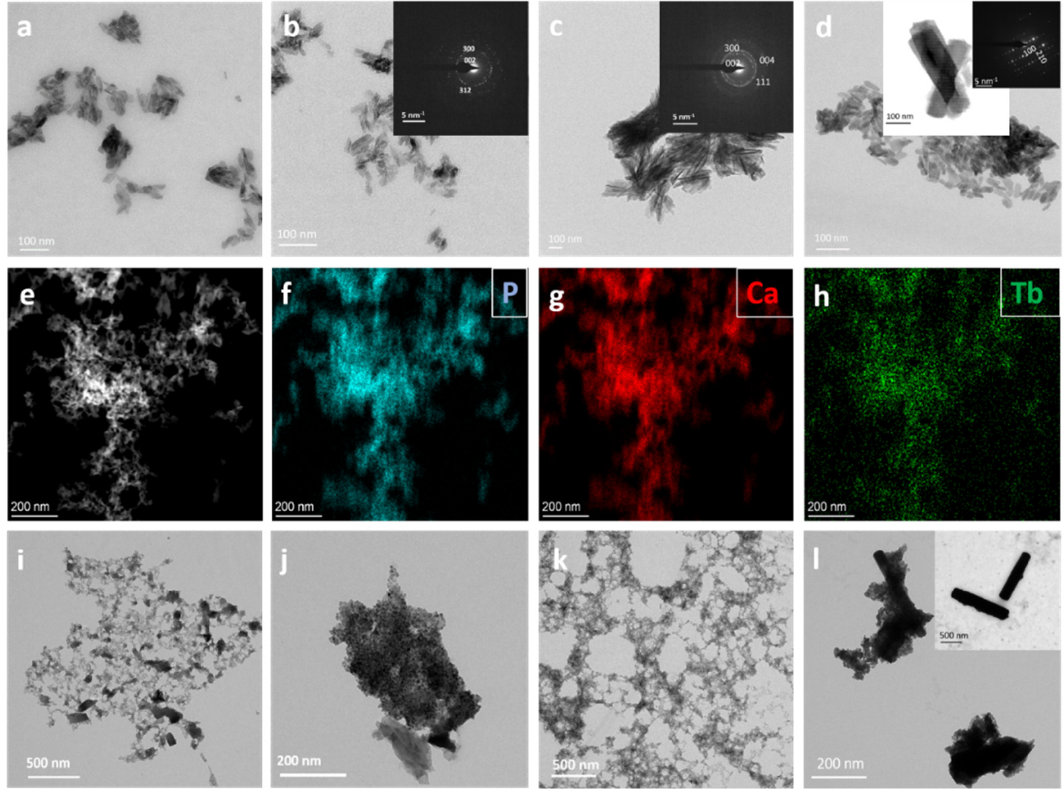
Figure 2. TEM images of Tb 3+ :cit-cAp particles prepared at different nominal Tb 3+ -doping concentrations ( x ) and maturation times: ( a ) x = 0 M, 96 h; ( b ) x = 0.001 M, 96 h; ( c ) x = 0.005 M, 96 h, insets show SAED patterns; ( d ) x = 0.010 M, 4 h; inset x = 0.010 M, 96 h, shows apatite prisms and the SAED pattern; ( e ) x = 0.001 M, 96 h, HAADF image; ( f , g , h ) EDX element mapping analysis of P, Ca and Tb; ( i ) x = 0.015 M, 4 h, (amorphous particles); ( j ) x = 0.015 M, 96 h, TbPO 4 ·H 2 O, amorphous TbPO 4 · n H 2 O, and apatite; ( k ) x = 0.020 M, 4 h, amorphous particles; ( l ) x = 0.020 M, 96 h, apatite